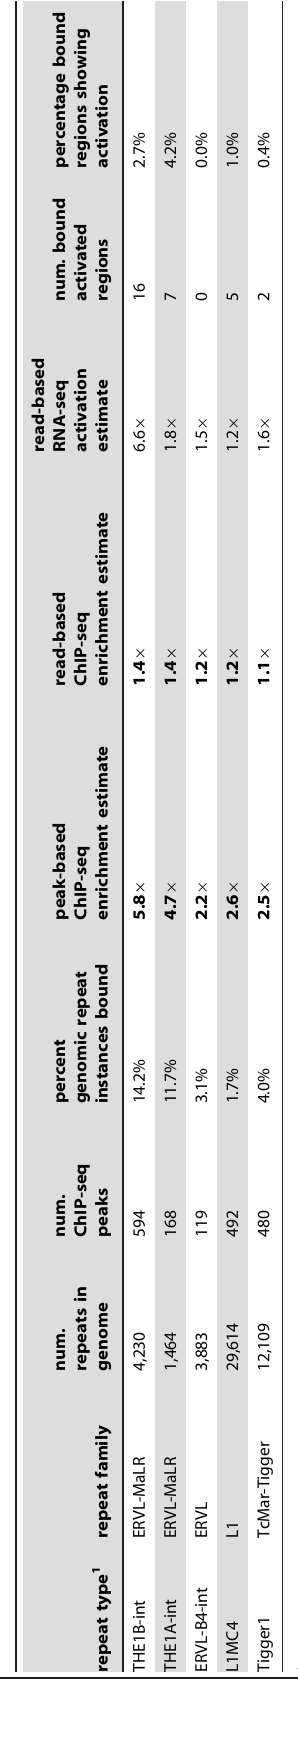
elements In order to determine whether DUX4 binding to repetitive elements results in their transcriptional activation, we generated RNA-seq data (100 nt single-end reads) from DUX4 -transduced and control myoblasts. In a conservative analysis, we identified 738 DUX4-activated transcripts within 1 kb on either side of a T